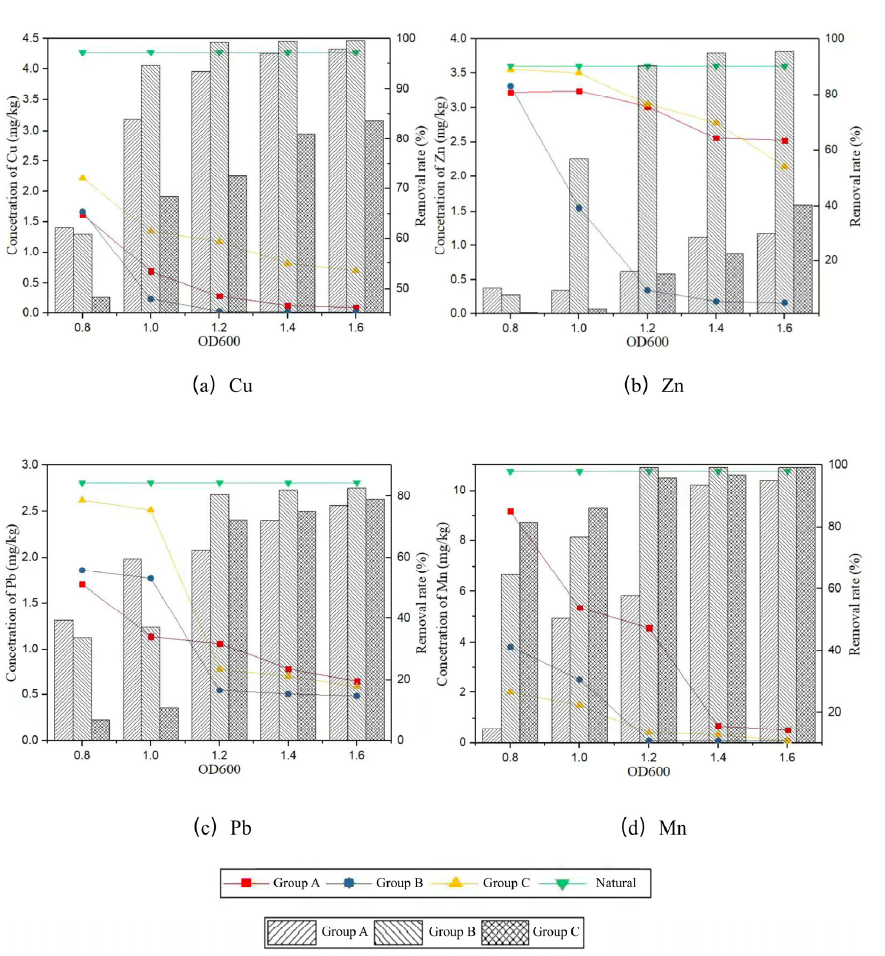
Figure 3. The solidification results of ( a ) Cu, ( b ) Zn, ( c ) Pb, ( d ) Mn under different bacterial con ‐